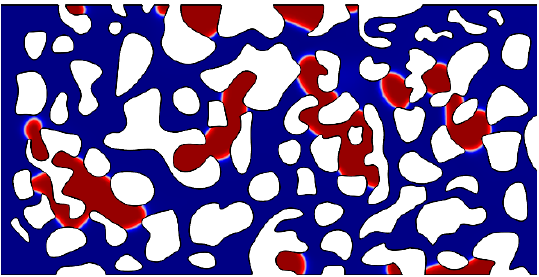
Figure 4. Residual oil distribution in the neutral-wet porous medium when the water cut is 98%. The white regions are rock matrix, and the red and blue regions represent oil and water, respectively.